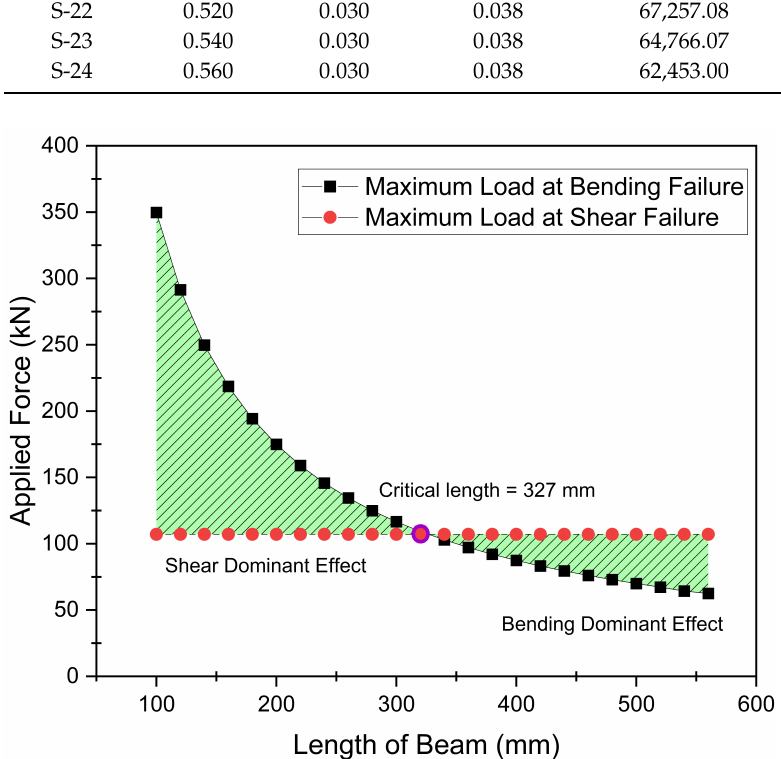
Figure 6. Determination of critical length for evaluation of bending and shear